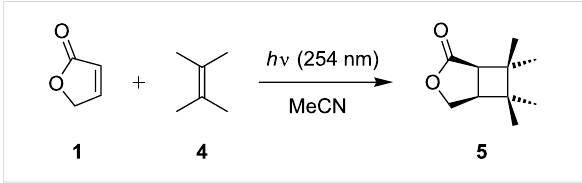
Table 1: Experimental results for the cycloaddition of 1 with 2 .